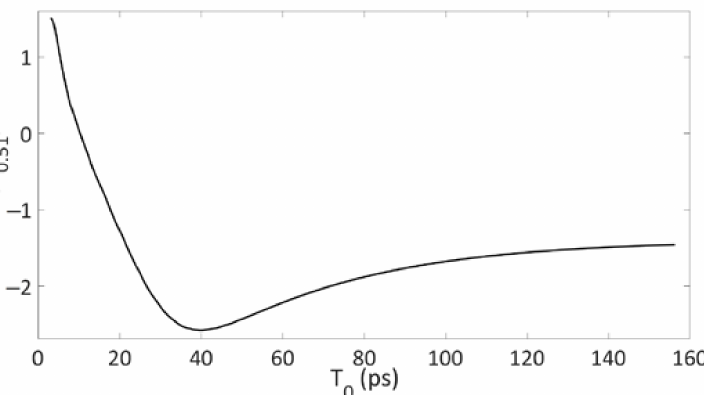
Figure 8. Natural logarithm of the deviation factor D between the theoretical and proposed 0.51th- order temporal differentiator for different temporal widths T 0 .